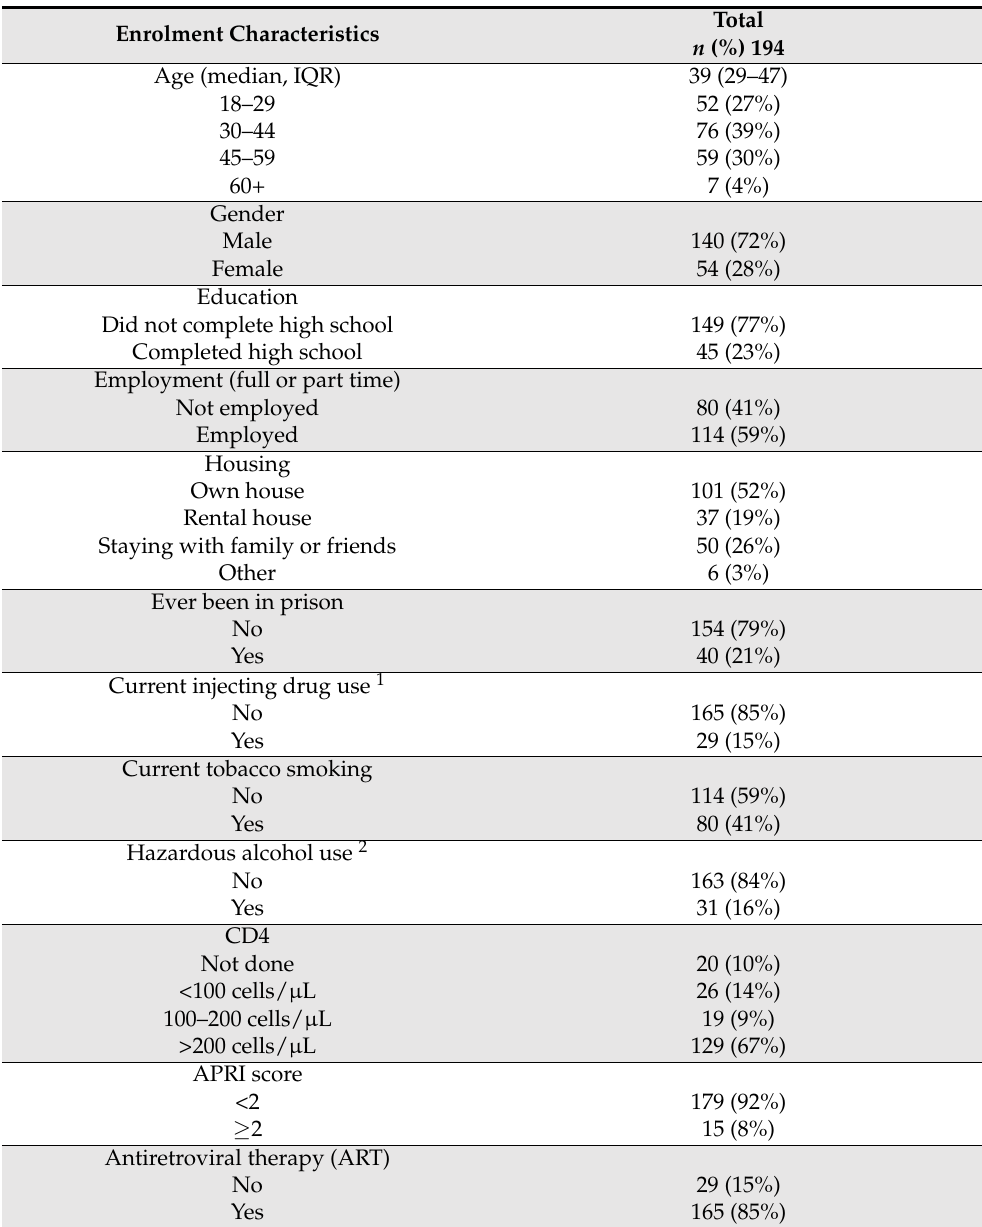
Table 1. Baseline socio-demographic and clinical